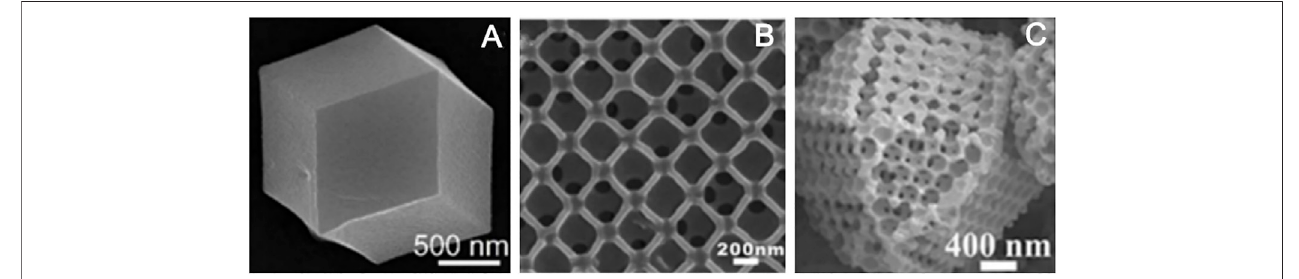
FIGURE 8 | SEM images of ZIF-8 (A) (Salunkhe et al., 2016); HKUST-1 (B) (Wu et al., 2011); and SOM-ZIF-8 (C) (Shen et al., 2018).